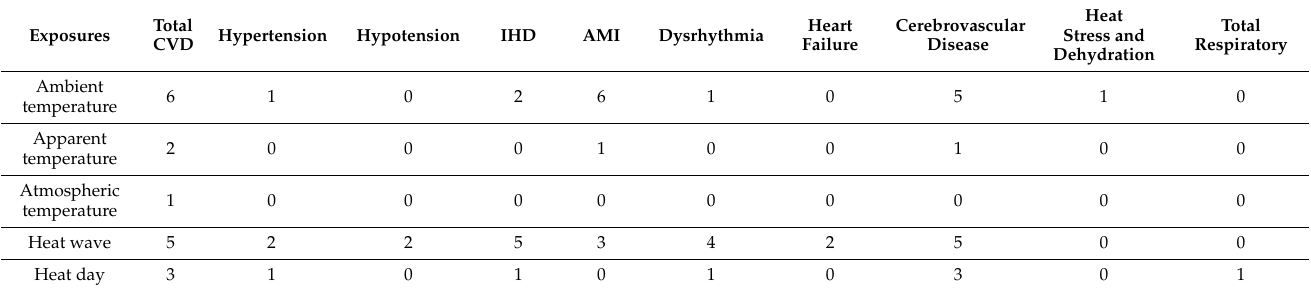
Table 2. Distribution of study exposures and examined